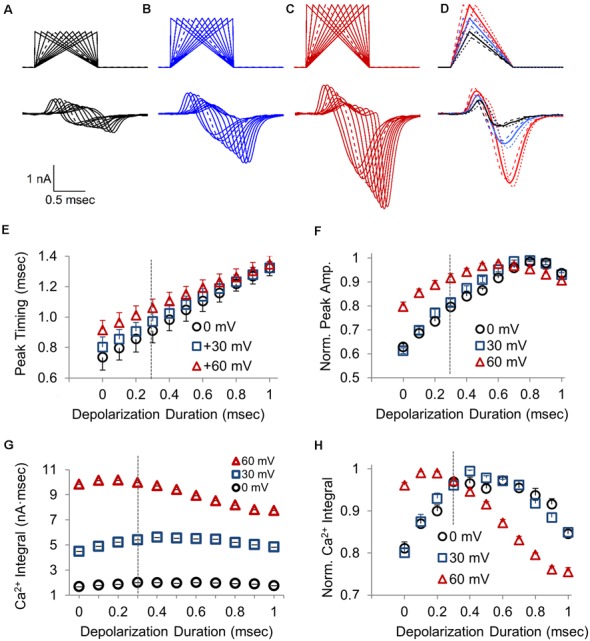
Changes in the calcium channel response resulting from differences in the duration of the depolarization and repolarization time for a 1 ms waveform stimulus. (A–C) Presynaptic CaV2 response to a series of 1 ms stimuli transitioning from a 0 ms depolarization followed by a 1 ms ramped repolarization to a 1 ms ramped depolarization followed by a 0 ms repolarization. Waveforms reached a peak voltage of 0 mV (A), +30 mV (B), or +60 mV (C). Dashed lines are the stimulus and response to an AP-like stimulation with 0.3 ms depolarization and 0.7 ms repolarization. (D) Overlay of presynaptic CaV2 responses to stimuli with a 0.2 (dashed), 0.3 (bold), or 0.4 (dotted) ms ramped depolarization and the remaining ramped repolarization to produce a 1 ms stimulus, with a peak amplitude of 0 mV (black), +30 mV (blue), or +60 mV (red). (E) The time required for presynaptic CaV2 response to reach peak amplitude, with stimulus onset as t = 0; n = 10 cells. (F) Normalized peak amplitude for the presynaptic CaV2 current at different depolarization to repolarization times with the indicated peak stimulus amplitudes. Each data-trace at 0, 30 and 60 mV was normalized to the peak amplitude for that trace, and the normalized traces were then averaged (n = 10 cells) to compare the relative changes in peak amplitude at different depolarization durations. (G) Presynaptic calcium entry measured as the integral of the CaV2 current; n = 10 cells. (H) Normalized presynaptic calcium integral for the CaV2 response. Each data-trace at 0, 30 and 60 mV was normalized to the peak amplitude for that trace, and the normalized traces were then averaged (n = 10 cells) to compare the relative changes in peak amplitude at different depolarization durations.